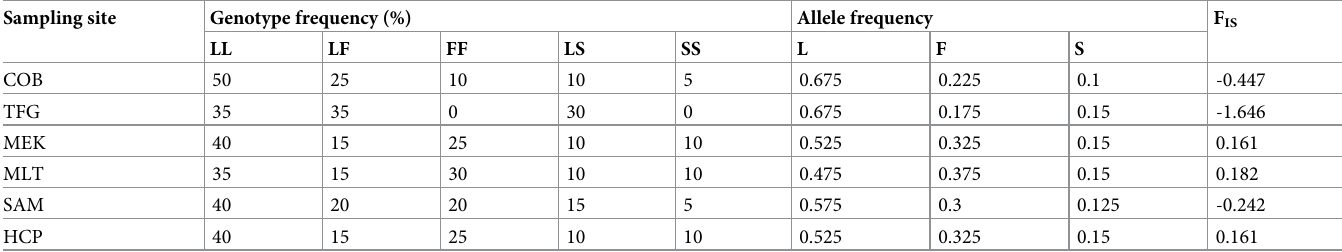
Table 5. Genotypic and allelic frequencies of L1014F and L1014S kdr mutations in Culex quinquefasciatus from two districts of West Bengal. Sampling